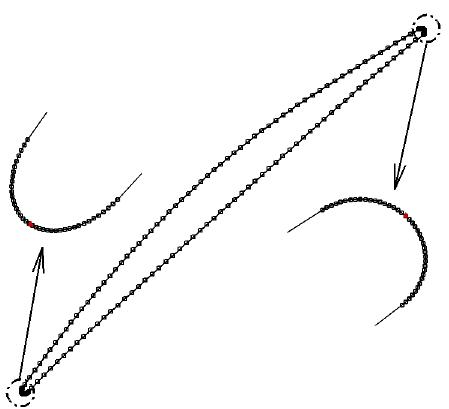
Figure 3. Blade profile and distribution of control points.